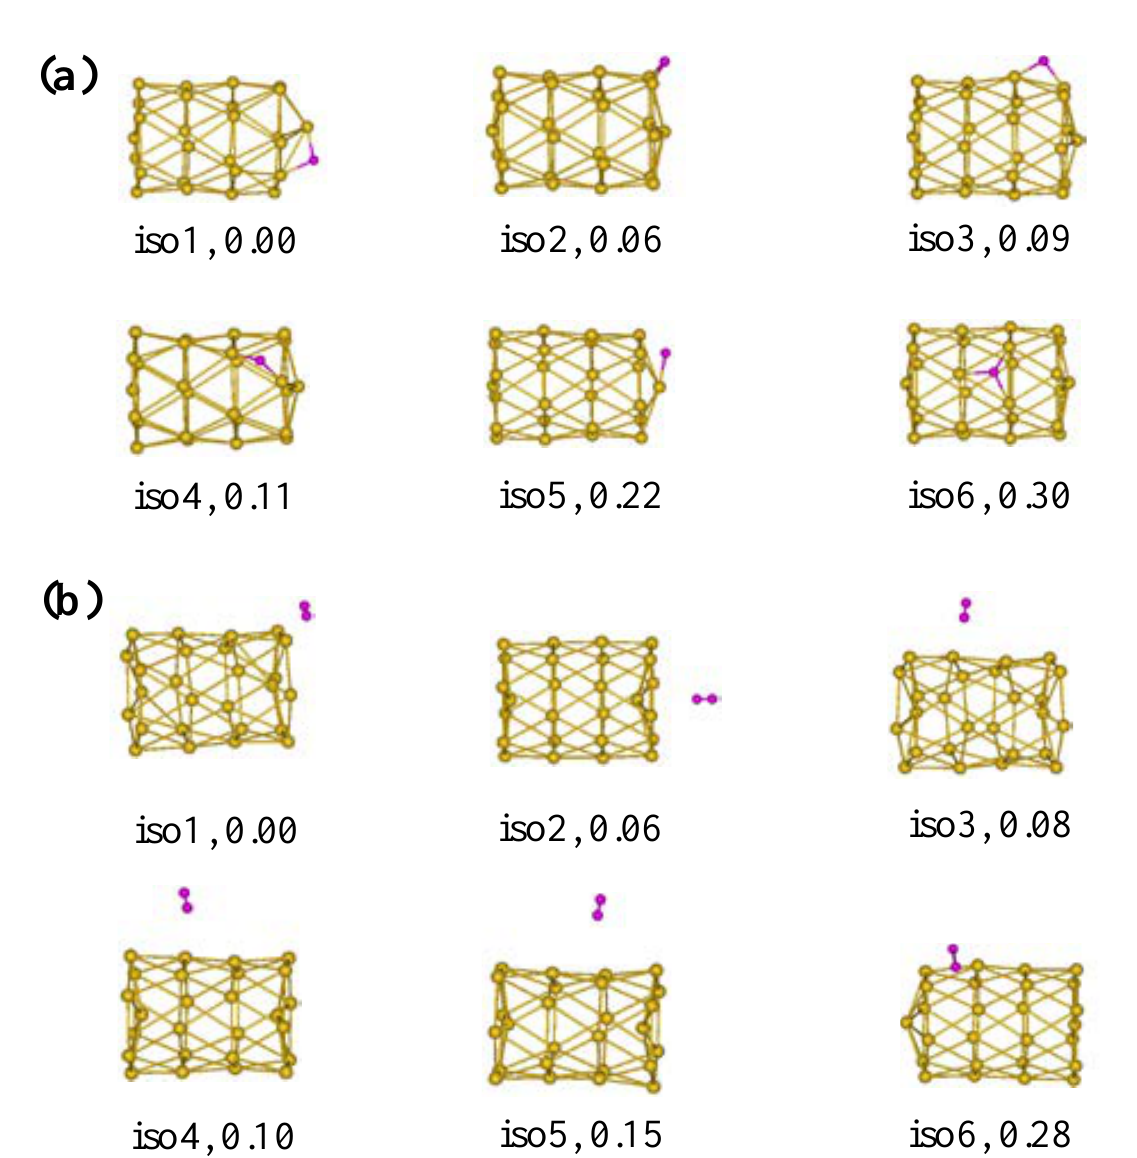
Figure 3. Isomer structures and relative stability of ( a ) Au 26 -H and ( b ) Au 26 -H 2 . Au, yellow; H, pink. Figure 3. I somer structures and relative stability of ( a ) Au The equilibrium bond length of a free H 2 molecule is computed to be 0.74 Å at the PBE0/Def2-TZVP level, which is in good agreement with the experimental value. Figure 4a shows the molecular orbitals and IR spectrum of the most stable iso1 of the Au 26 -H 2 .